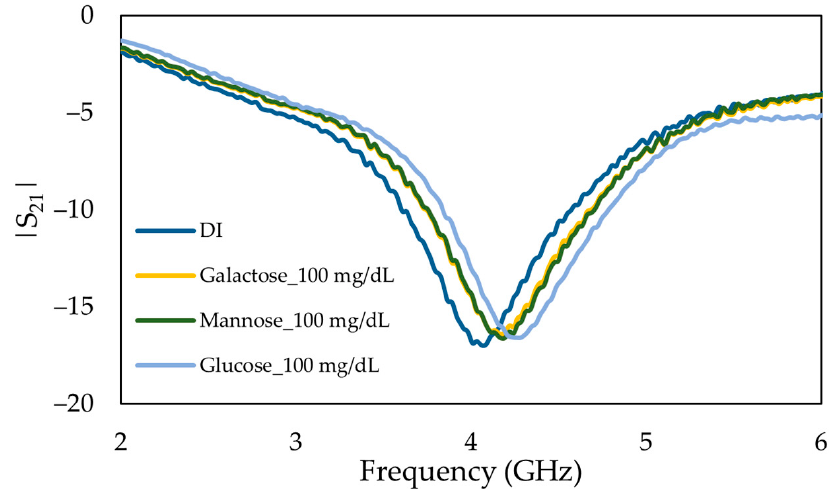
Figure 14. Measured frequency response of the insertion loss (S21) of main MIP-coated microwave- based stub biosensor exposed to 100 mg/dL of glucose, mannose, and galactose solutions.